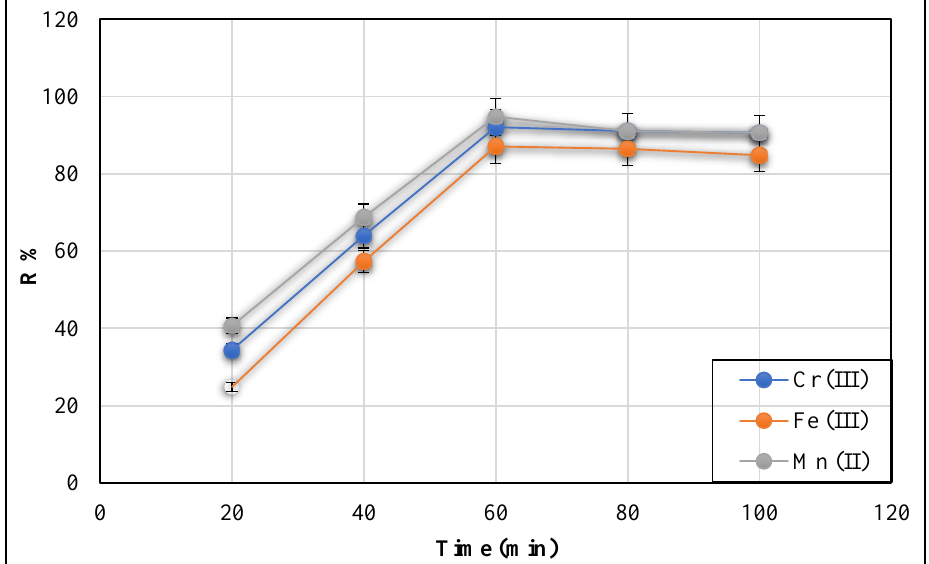
Figure 15. Effect of mixing time on Cr (III), Fe (III), and Mn (II) removal onto Ch/g-HNTs@Zn γ M adsorbent.